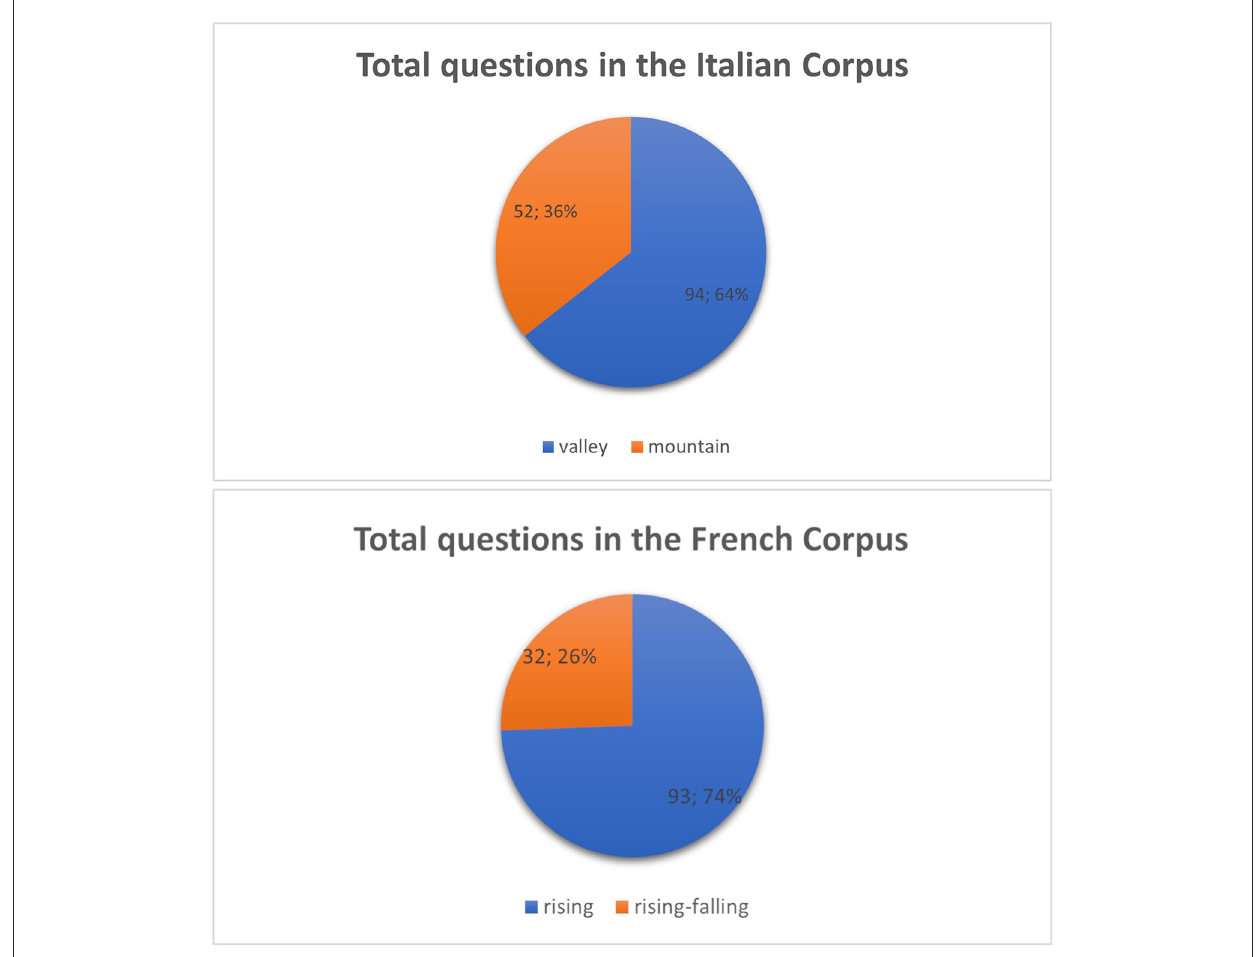
FIGURE3 Total questions in the French and Italian